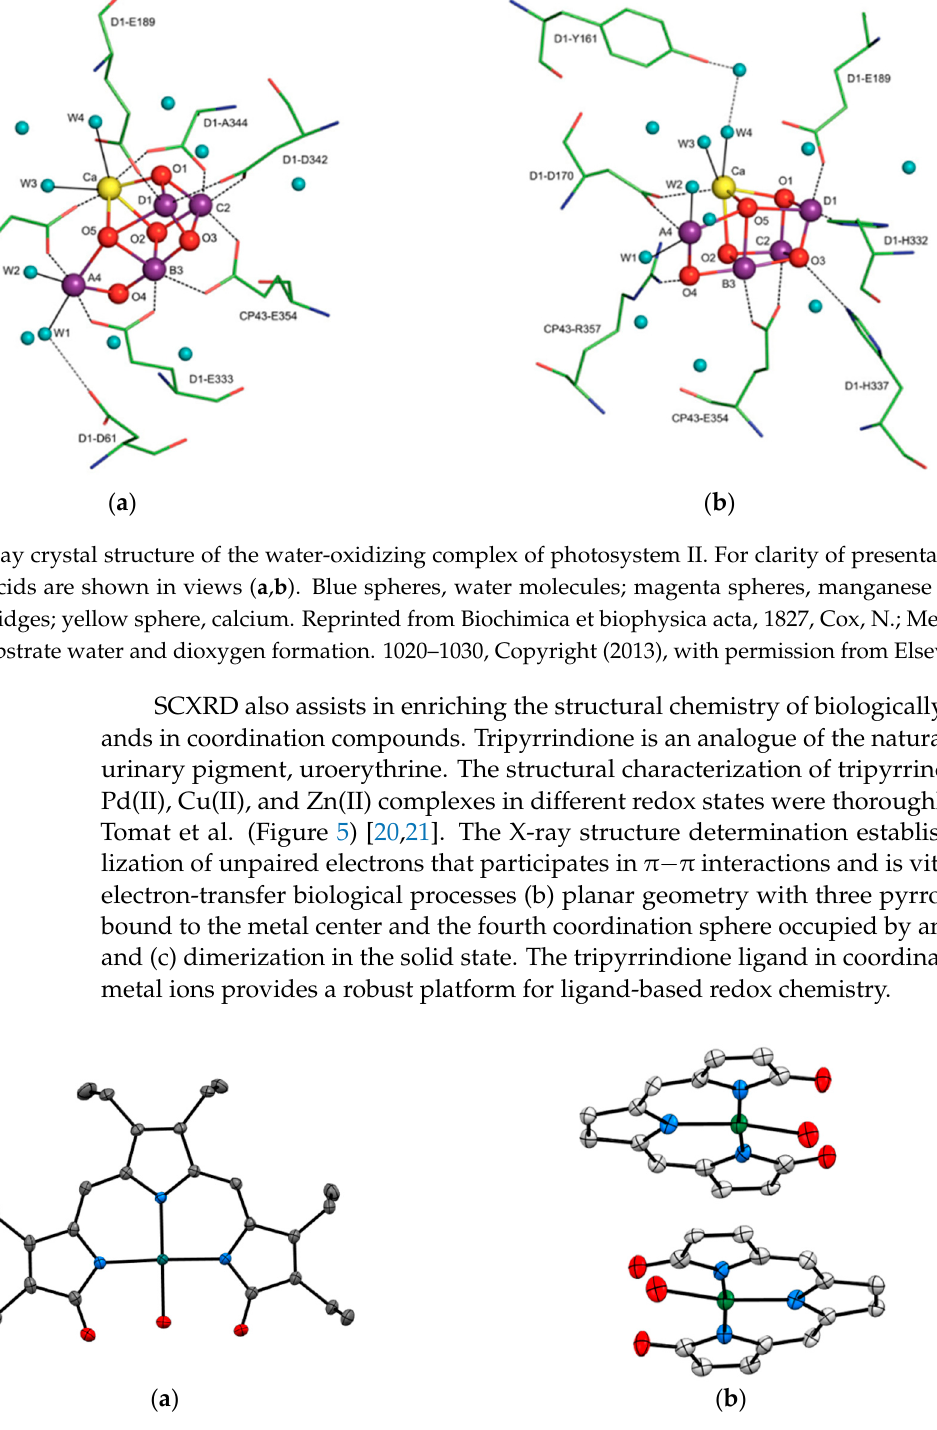
Figure 5. Crystal Structure of tripyrrindione transition metal complexes. ( a ) Top view of [Pd(TD1•)(H 2 O)] (CCDC 1400990) and ( b ) Stacked view of [Cu(TD1•)(H 2 O)] (CCDC 1452414). Hydrogen atoms are omitted for clarity. Ref. [20,21] .